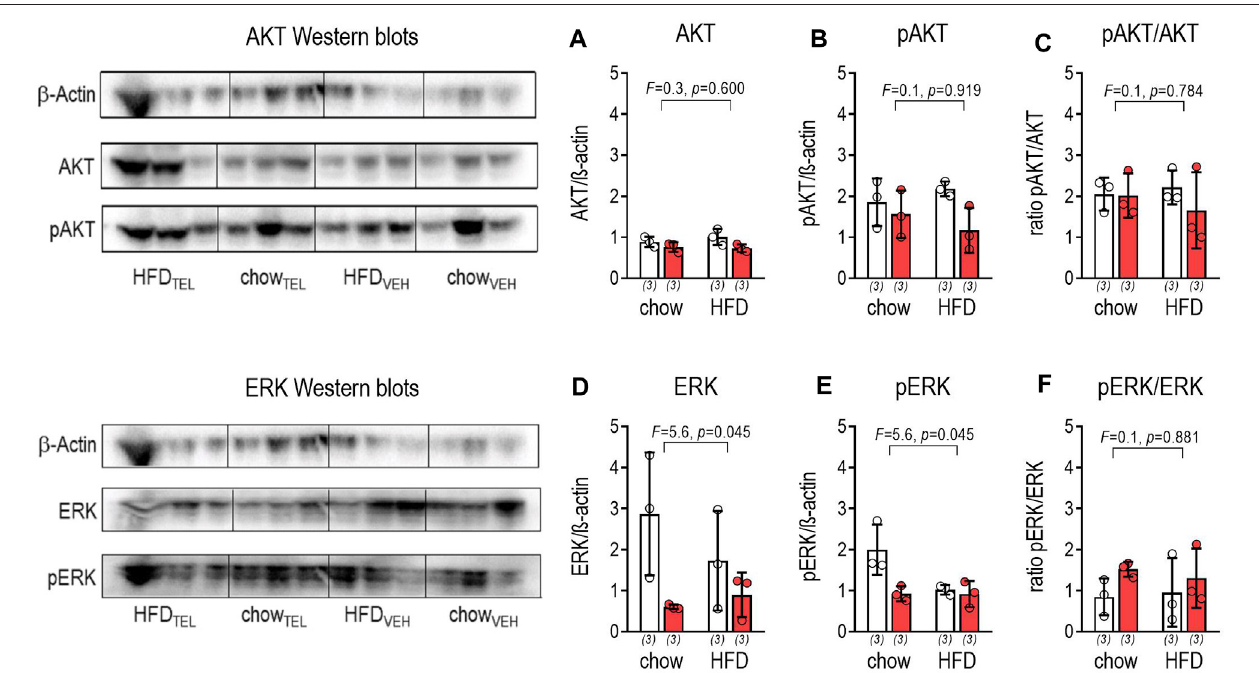
FIGURE6| EffectsofTEL( C ,8 mg/kg/dayredbars)orvehicletreatmentopenbars (O)onproteinexpression ofAKTand ERKonlargeintestineofchow-orHFD- fed mice. (A) AKT/ β -actin ratio (two-way ANOVA; TEL: F = 6.3, p = 0.037; interaction; F = 0.8, p = 0.386); (B) pAKT/ β -actin ratio (two-way ANOVA; TEL: F = 5,1, p = 0.054; interaction; F = 0.6, p = 0.761); (C) pAKT/AKT ratio (two-way ANOVA; TEL: F = 0.7, p = 0.418; interaction; F = 0.5, p = 0.476); (D) ERK/ β -actin ratio (two-way ANOVA;TEL: F =7.2, p =0.028,interaction; F =1.5, p =0.249); (E) pERK/ β -actinratio(two-wayANOVA;TEL: F =7.9, p =0.0027,interaction; F =5.4, p =0.049); (F) pERK/ERK ratio (two-way ANOVA; TEL: F = 2.2, p = 0.180, interaction; F = 0.2, p = 0.654). Means ± SD, means ± SD (n = 3).